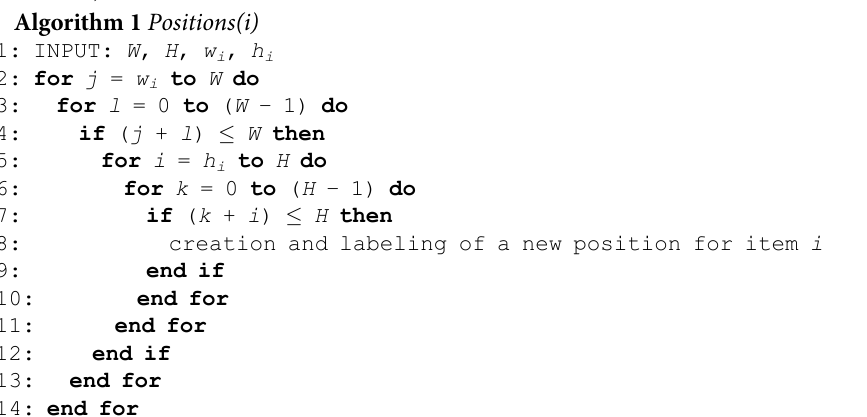
Algorithm 1 depends on the size of the instance: the size of the bin and the total of items (see Theorem 1).